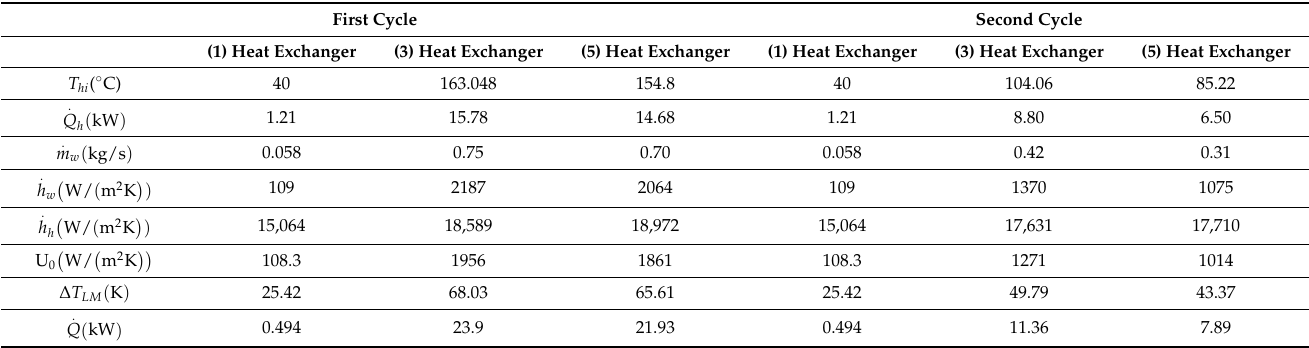
Table 6. Required performance of the heat exchanger in the first and second